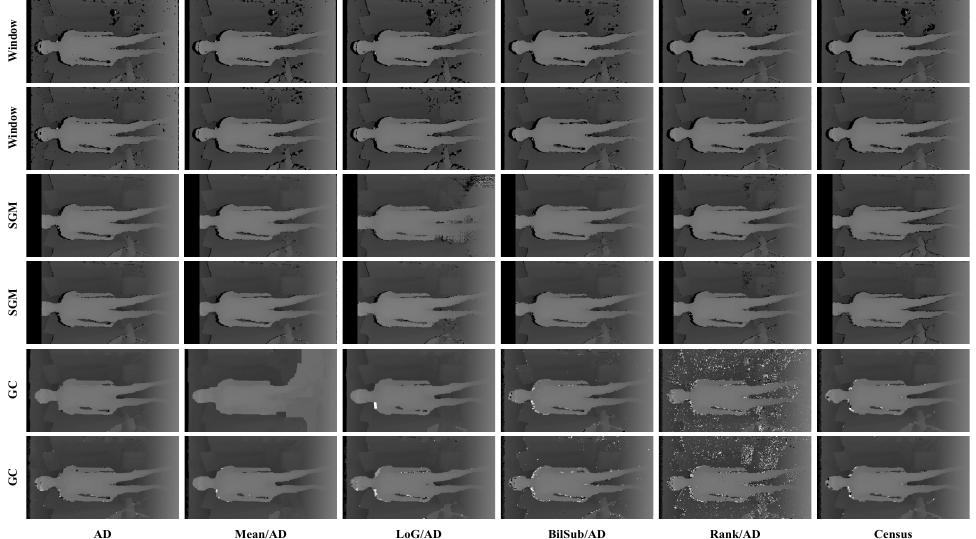
Figure 32. Estimated real disparity images of the combinations of cost and image filter using each stereo matching method, according to the gain parameter. The upper line indicates the low parameter, and the lower line indicates the high parameter for each stereo matching method,